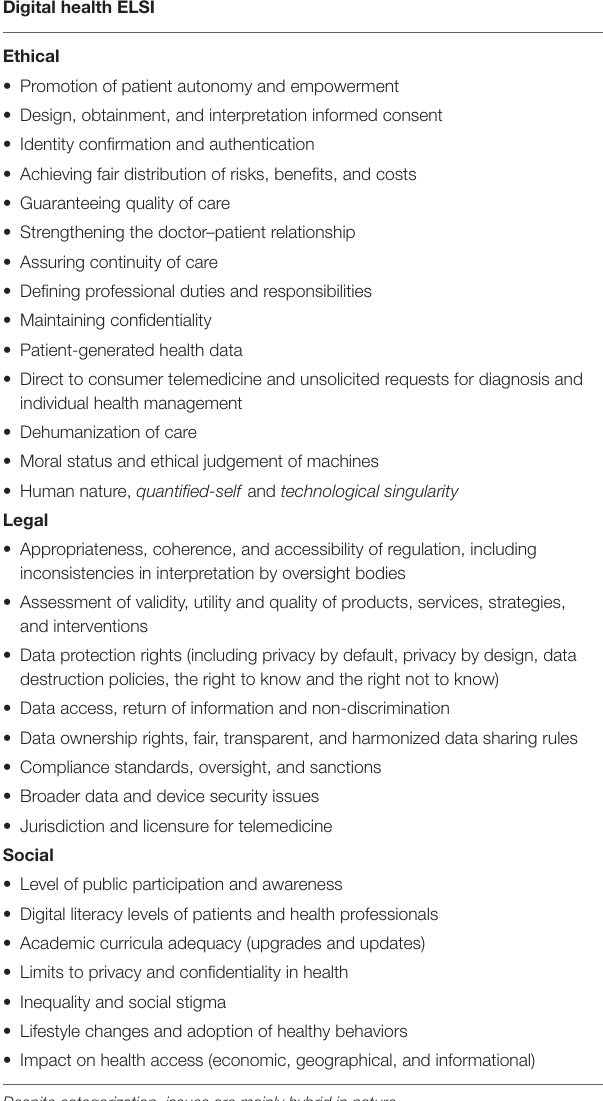
TABLE 1 | Summary of relevant ethical, legal, and social issues (ELSI) raised by digital technologies and health data processing in